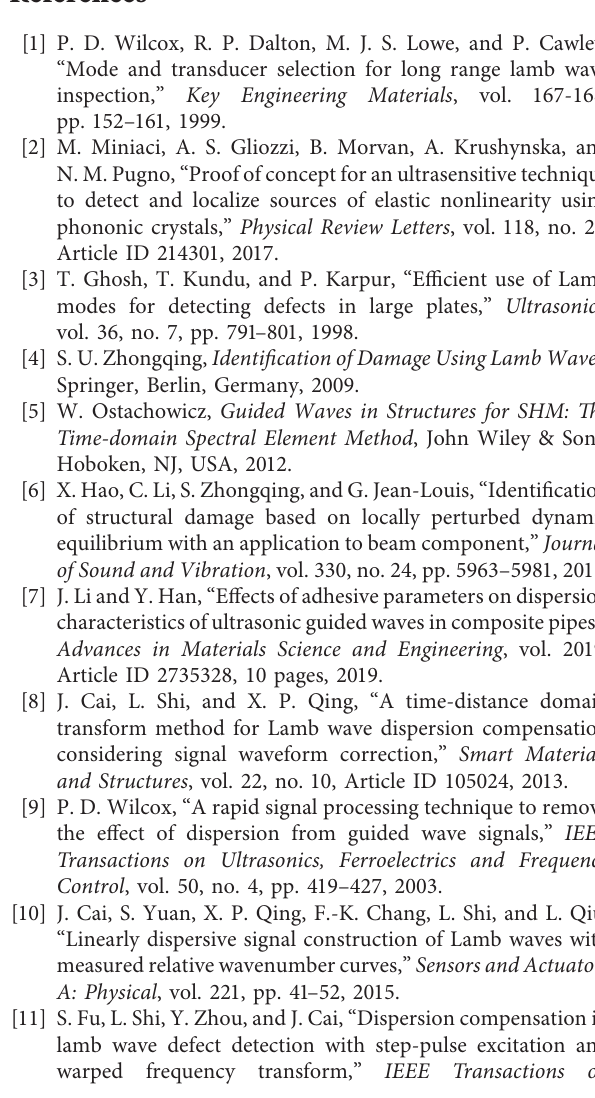
Figure 8: Procedure of ∆ K-DC with the unknown wavenumber: (a) spectrum of the excitation signal Y ( 0 , ω ) ; (b) spectrum of the direct A ( r, ω ) ; (c) phase spectrums Φ ( 0 , ω ) , Φ ( r, ω ) , an d ΔΦ ( ω ) ; (d) wavenumber curves K ( ω ) ,K ( ω ) , an d Δ K ( ω ) ; (e) SAP 2 of the wave Y A 0 lin ′ ( r,t ) (direct A raw signal in Figure 7; (f) phase compensation result for the direct A 0 wave Y 0 wave); (g) phase compensation result for the lin ( r,t ) ∆ K-DC result after correction Y ′ ( r,t ) (reflected A reflected A 0 wave Y 0 wave); (h) lin lin